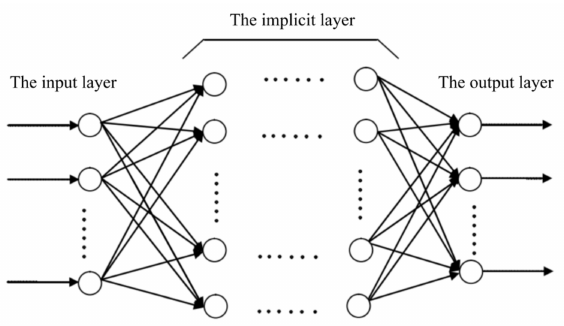
Figure 1. Neural network structure.